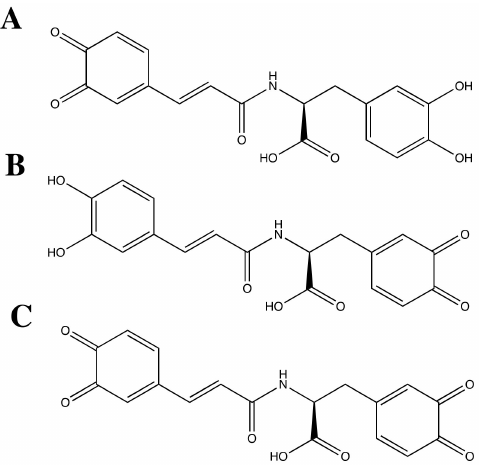
Figure 3. The three ortho-quinone derivatives of clovamide. ( A ) ortho-quinone group at the extended double-bond conjugation side of the molecule; ( B ) quinone group at the non-conjugation (less rigid) side of the molecule; ( C ) ortho-quinone groups substituted for both of the catechol